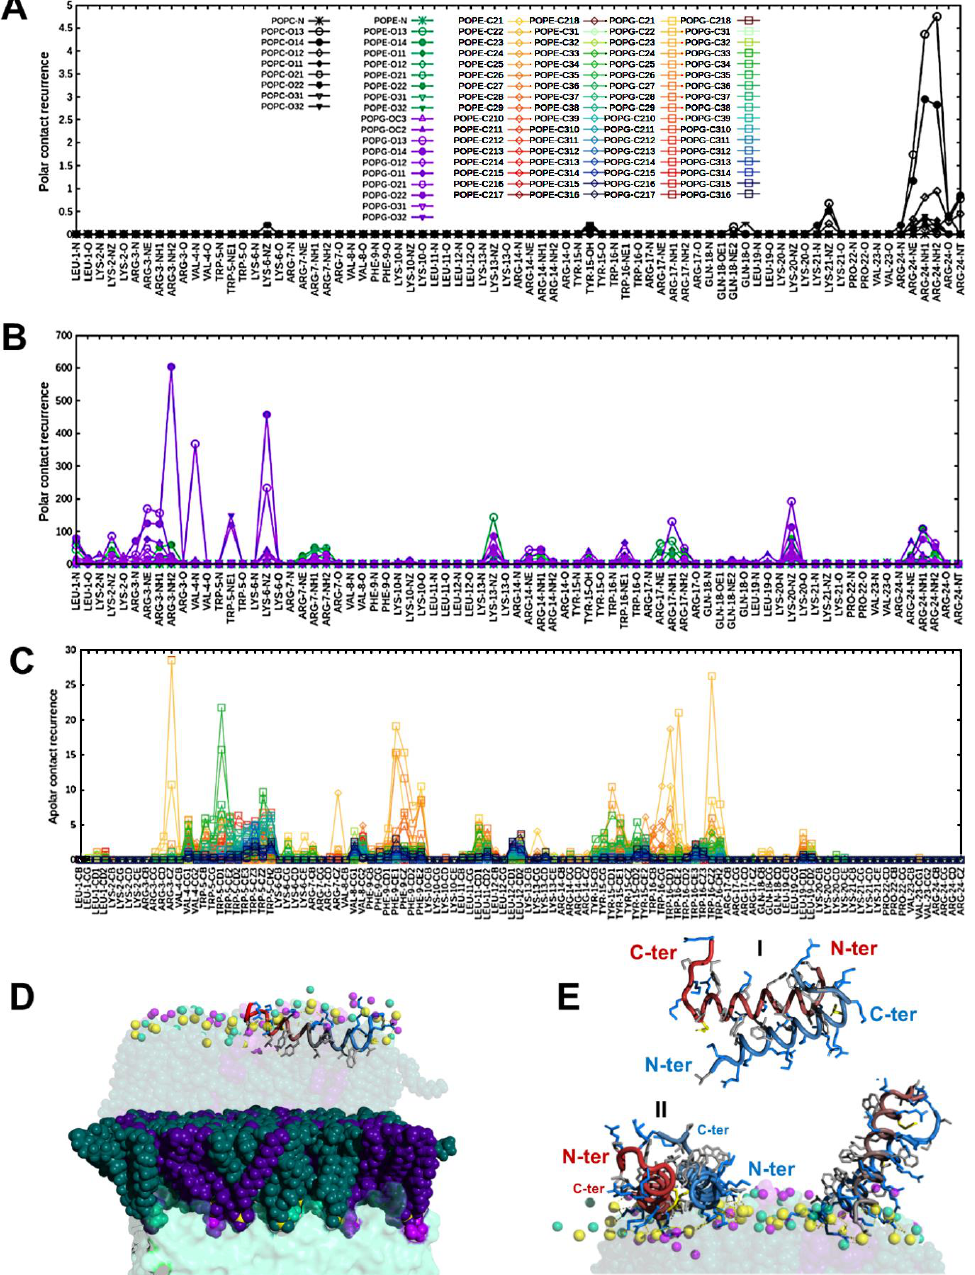
Figure 5. ( A , B ) Recurrence of polar atom contacts (H bonds and salt bridges) between SAAP-148 peptide and POPC ( A ) and POPE/POPG ( B ) bilayers calculated along MD simulation trajectories. ( C ) Recurrence of van der Waals contacts between SAAP-148 peptide and POPE/POPG bilayers calculated along MD simulation trajectories. ( D ) MD snapshot of SAAP-148 interacting with POPE/POPG bilayers in the presence of Ca 2+ ion. Color code: phosphorus atom: yellow, POPE: dark green (body), turquoise (headgroup), light green (amine of the headgroup); POPG: dark violet (body), violet (headgroup), light violet (hydroxyls of the headgroup). For clarity, only functional groups of headgroups are shown (spheres) in the upper leaflet. SAAP-148 is shown as a ‘tube’ colored from blue (N-terminus) to red (C-terminus). Sidechains are shown as sticks with the following color code: positively charged (blue) and nonpolar (light gray). ( E ) SAAP-148 dimers found along the trajectory and interacting with POPE/POPG bilayers. In the dimer, the two units (colored in red and blue) can arrange in antiparallel (I) or parallel fashion (II).